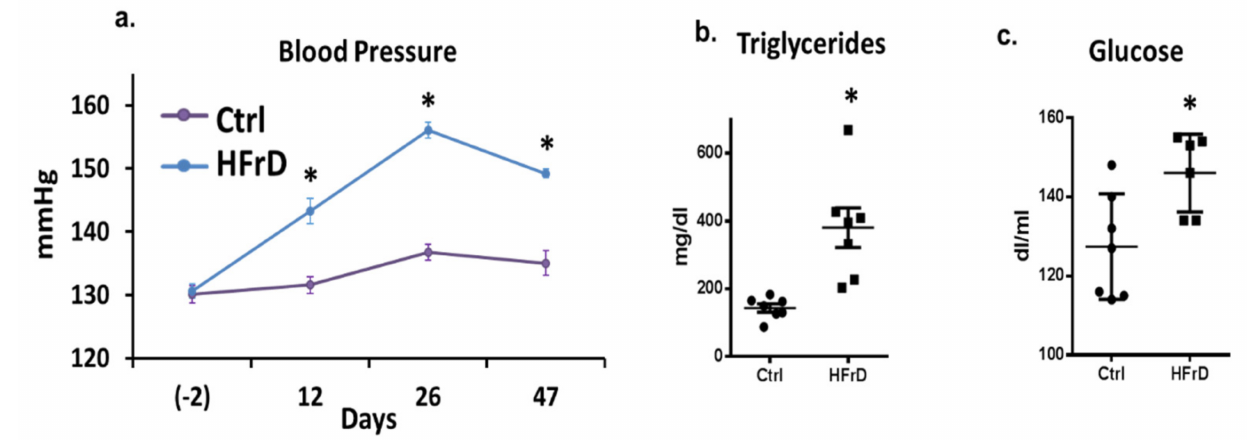
Figure 1. High-fructose diet (HFrD)-fed rats developed hypertension and increased blood triglyc- erides and glucose level. Blood pressure (BP) was measured using tail cuff ( a ). Blood triglycerides and glucose were measured at the end of the experiment ( b , c ). * p ≤ 0.05. n = 7–8.